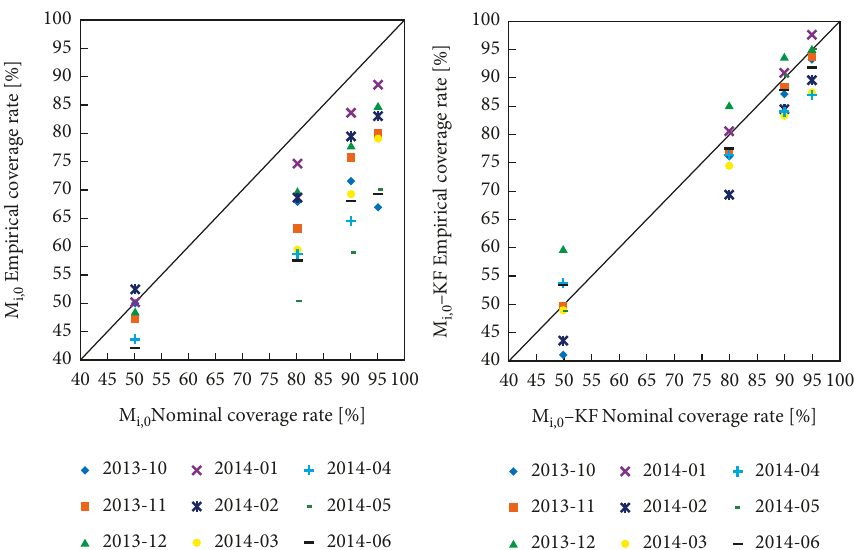
Figure 11: Association diagram between monthly rate of empirical coverage and monthly rate of nominal coverage for the intraday solar GHI prediction with regard to the prediction interval of the ensemble prediction during the period from October 2013 to June 2014.